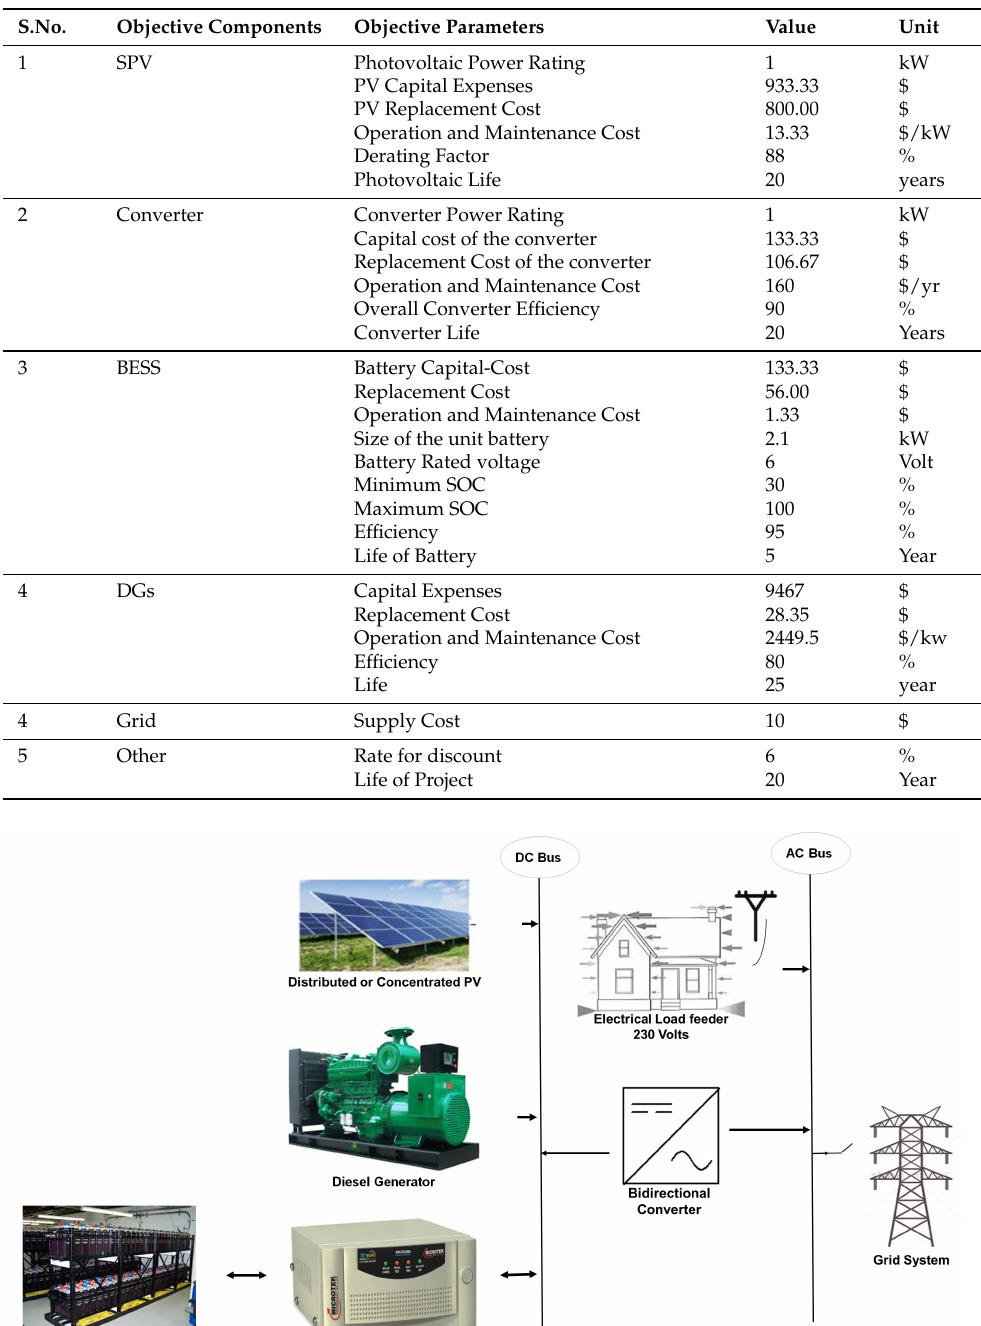
Table 2. Techno-economic data associated with the different components of the proposed system.